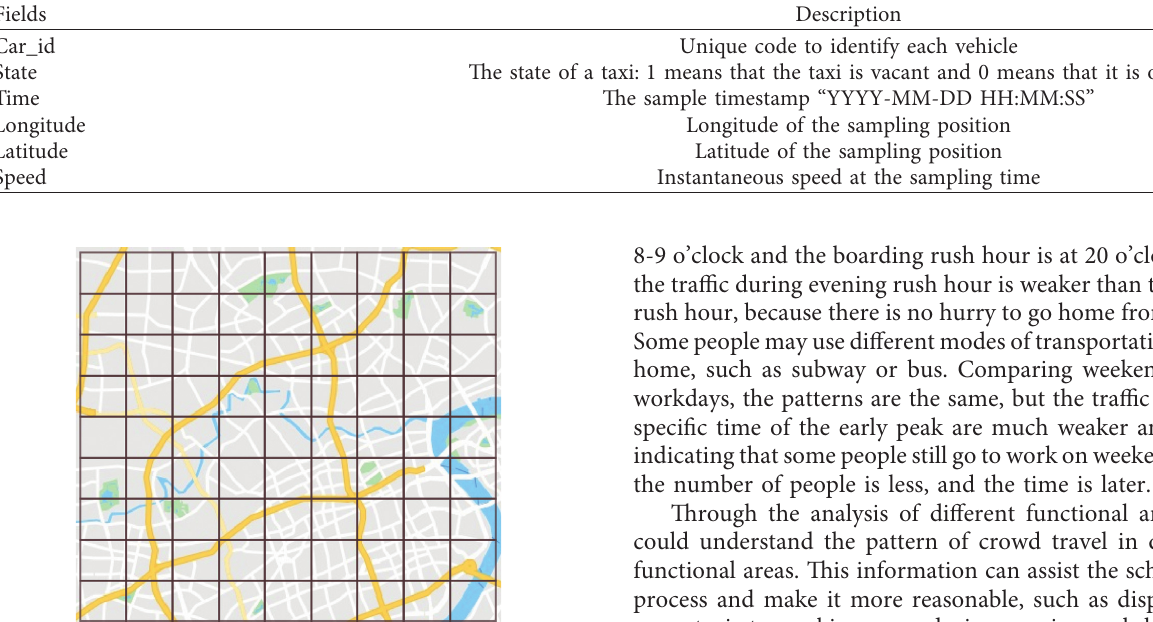
Figure 2: Partition result.